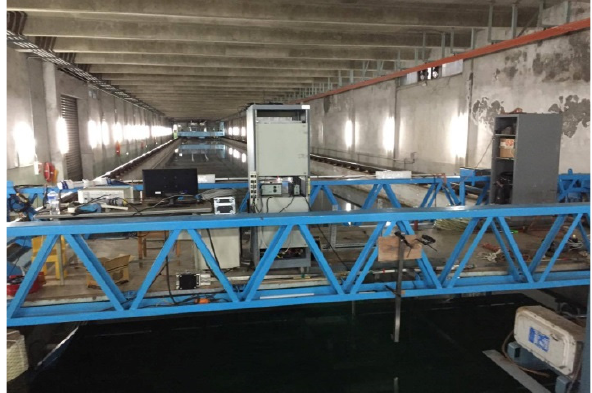
Figure 6. The standard measurement system of detecting acoustic waves in the Underwater Acoustic Laboratory of the Department of Marine Engineering of Taiwan University. After the standard hydrophone is calibrated, the FBG hydrophone and standard hydrophone are located 2 m away from the acoustic wave source for receiving the same level of acoustic wave pressure. The separation between the FBG hydrophone and standard hydrophone is 1 m to avoid mutual interference, as shown Figure 7. Finally, the